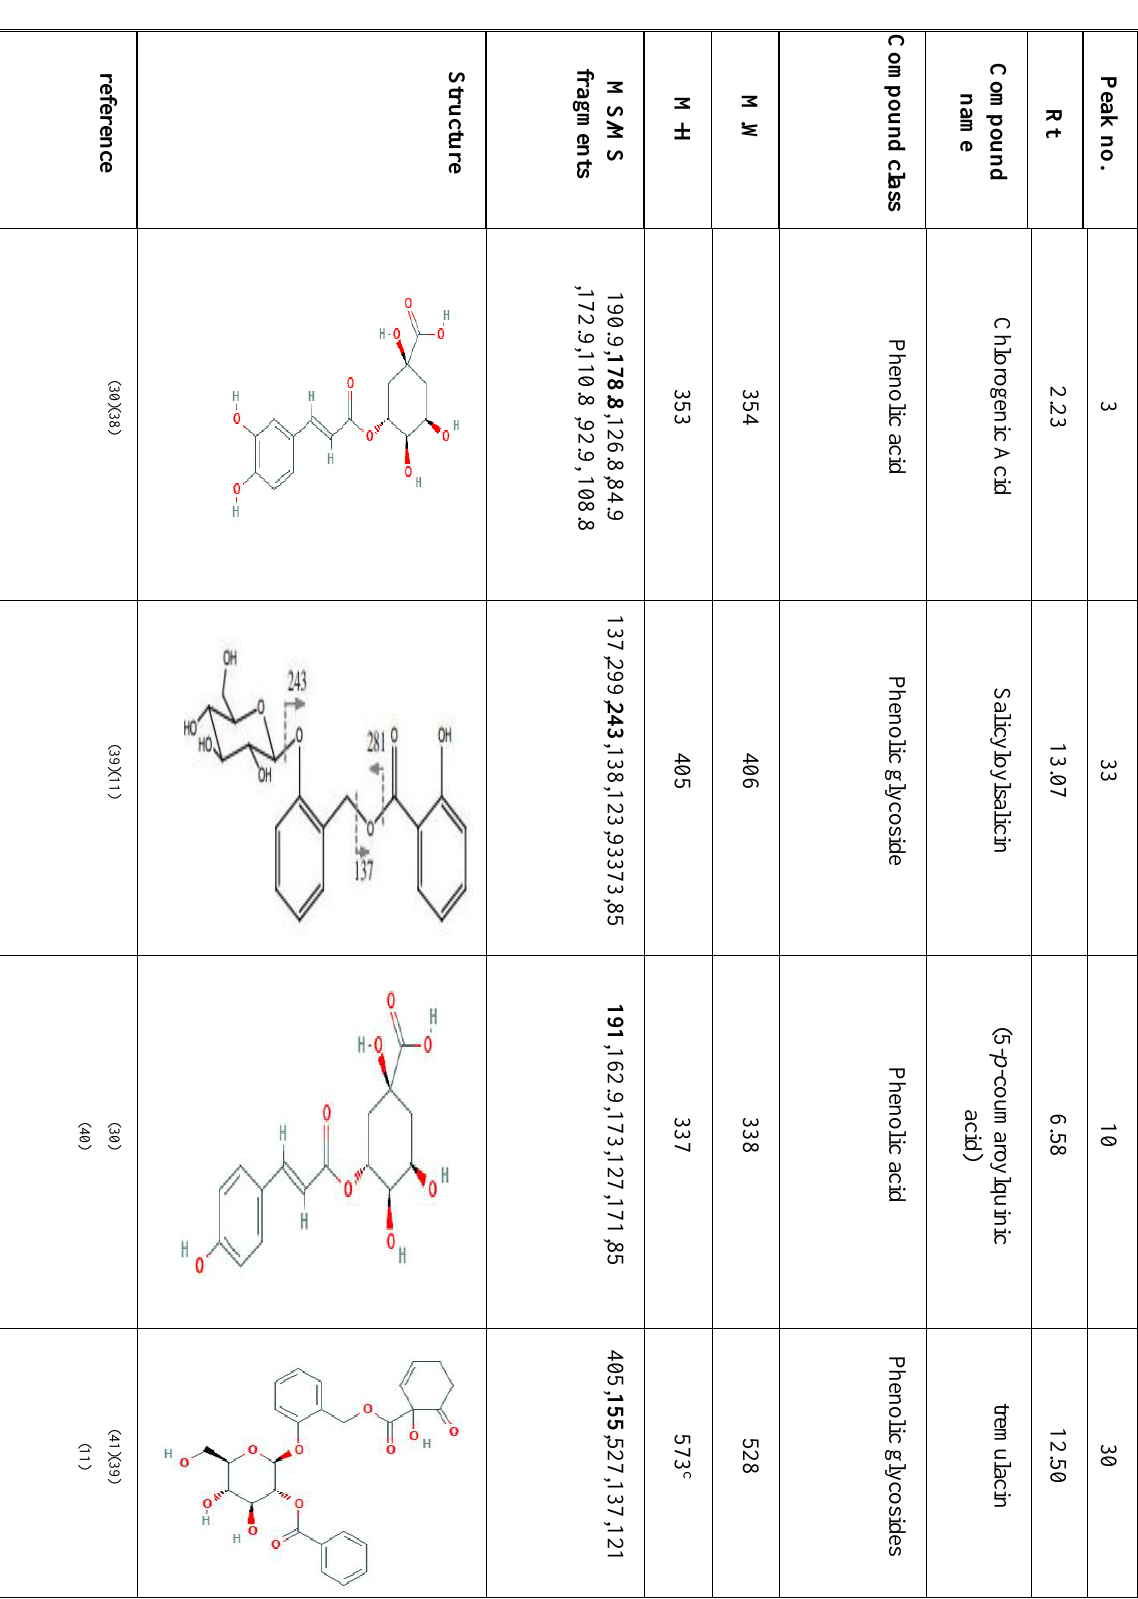
Table 6. UPLC-ESI-MS/MS of B.A